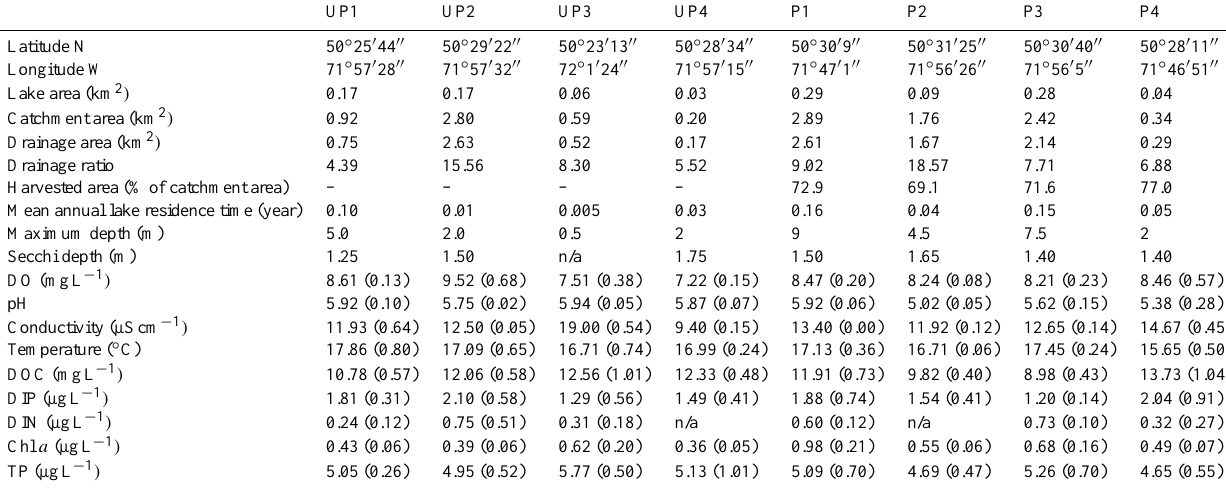
Table 1. Characteristics of the eight studied Canadian Boreal Shield lakes (UP: unperturbed lakes; P: perturbed lakes). Dissolved oxygen (DO), pH, conductivity, temperature, Secchi depth, total phosphorus (TP), dissolved inorganic phosphorous (DIP), dissolved inorganic nitro- gen (DIN), chlorophyll a (chl a ) and dissolved organic carbon (DOC) are reported as means (SD) over the sampling stations on the photic zone before the perturbation (2008). Lake UP3 was not deep enough to sample Secchi depth. UP1